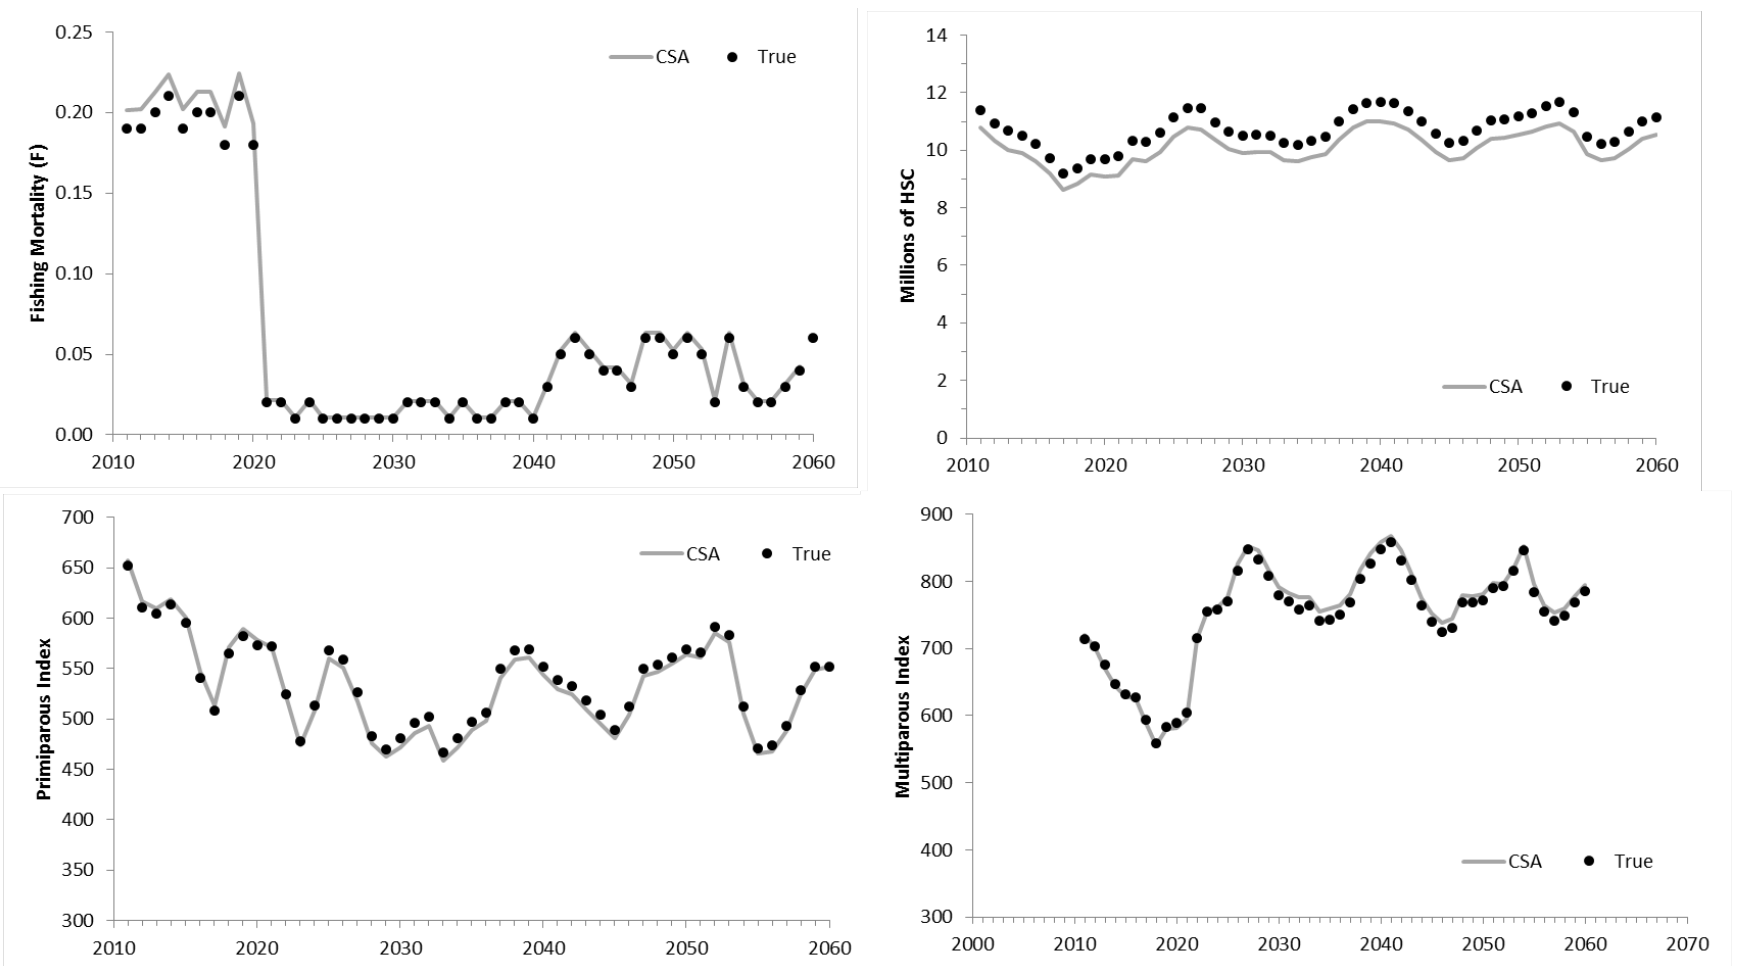
Figure 100. Comparison between simulated “true” data from the operating model and catch survey analysis (CSA) results for simulation